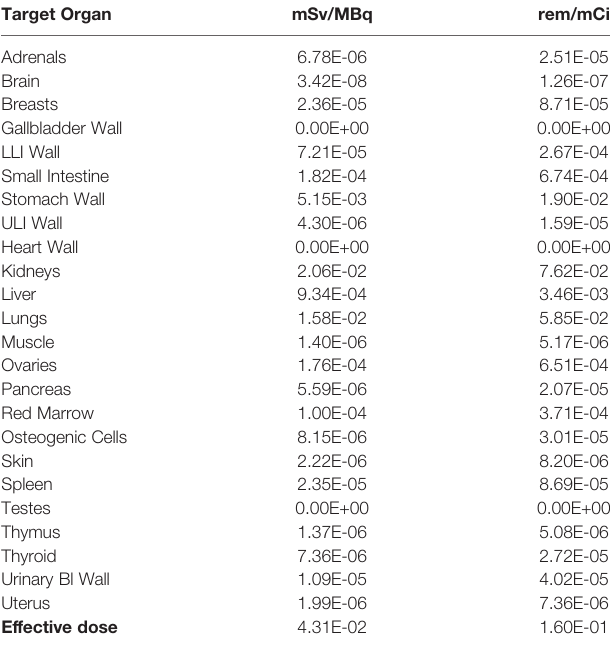
TABLE 3 | Expected absorbed doses of 177 Lu-DOTA integrin a v b 6 knottin in humans. Target Organ mSv/MBq rem/mCi